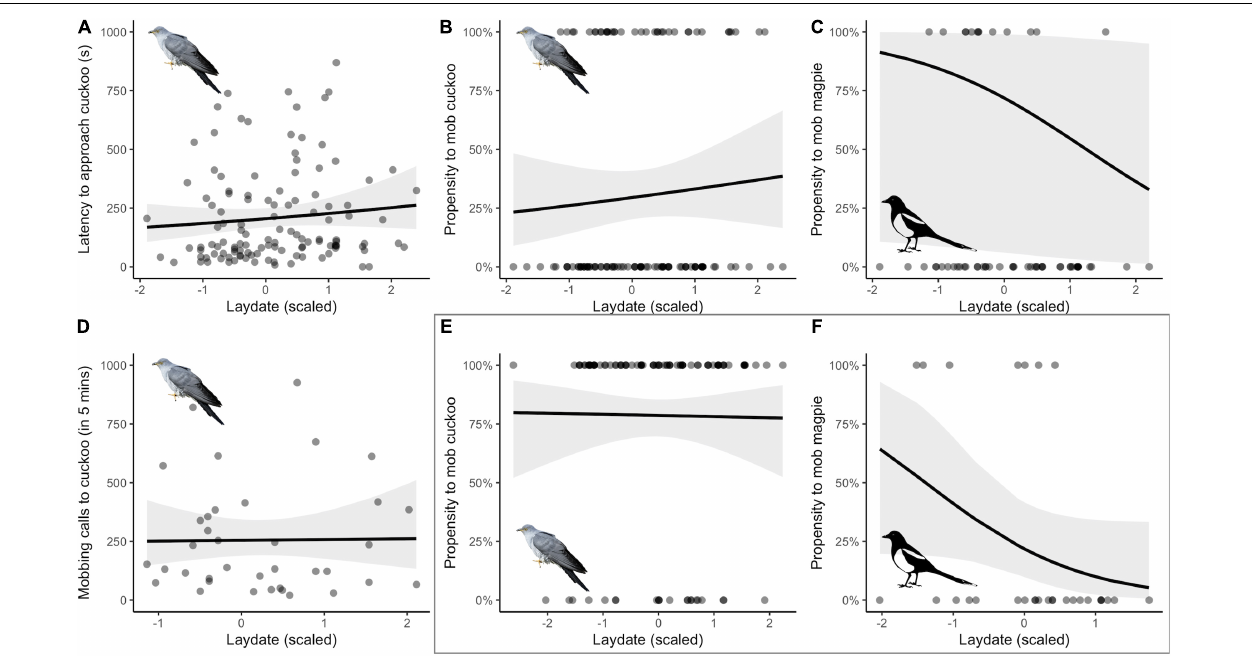
FIGURE 2 | Investigating potential effects of re-nesting potential (estimated using laying date scaled relative to breeding season) on reed warblers’ (A) latency to approach (s) and (B,E) propensity to mob (using bill snaps and rasp calls) a cuckoo model presented at the nest, and (C,F) propensity to mob a model nest predator (magpie). (D) presents the intensity of mobbing (number of calls per 5 min) at nests with positive propensity in panel (B) . Panels (A–D) represent behavior at non-parasitized sites in Finland, (E,F) (in box) show data from parasitized sites in Italy (previously published in Campobello and Sealy, 2010). Solid lines ( ± 95% confidence intervals, shaded) indicate the relationship from generalized linear mixed effect models (A–D) and generalized linear models (E,F) ; no relationships were significant (see Table 2